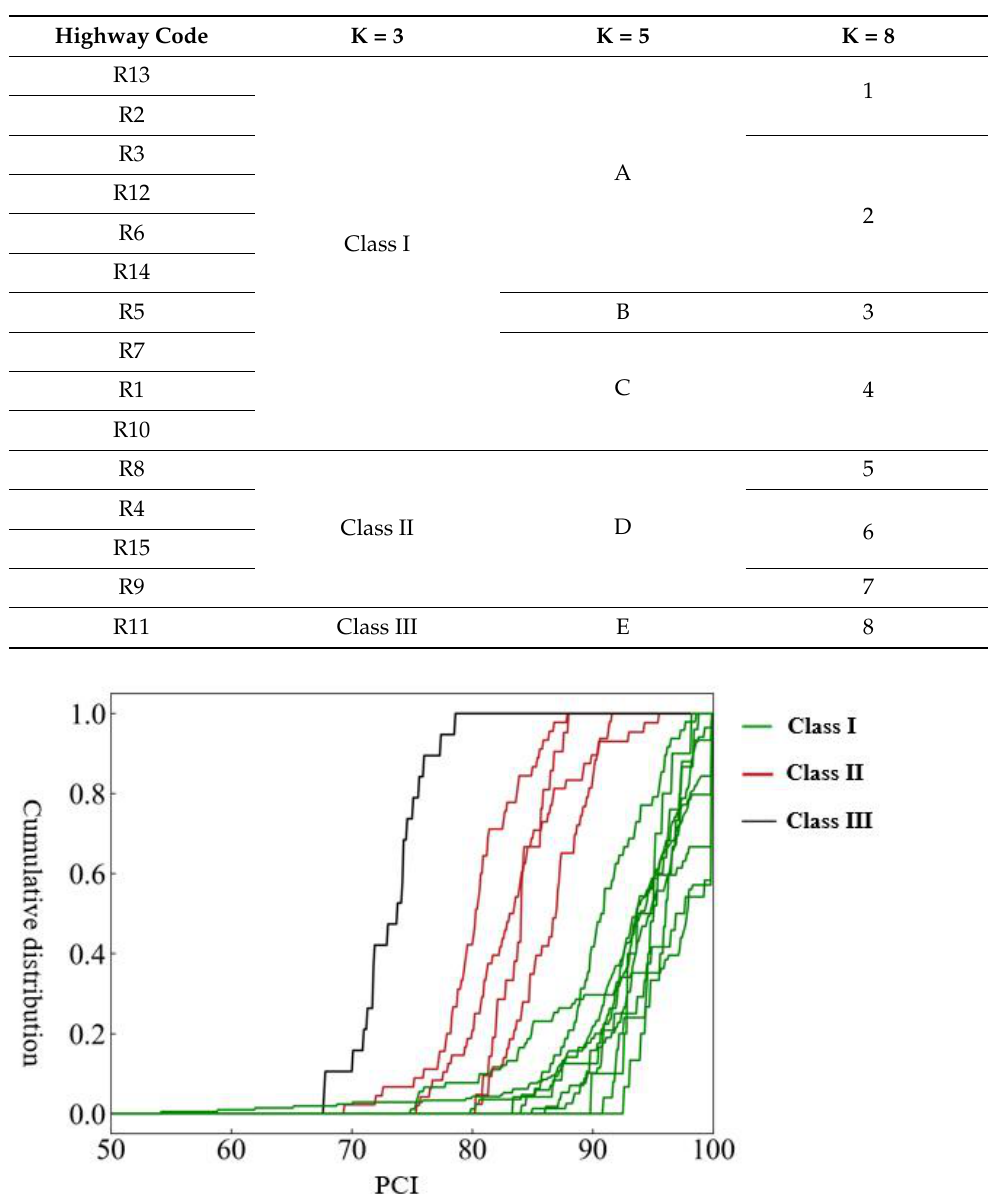
Figure 2. The relationship between SSE and the number of classes. Table 2. Summary of clustering results. Table 2. Summary of clustering results.